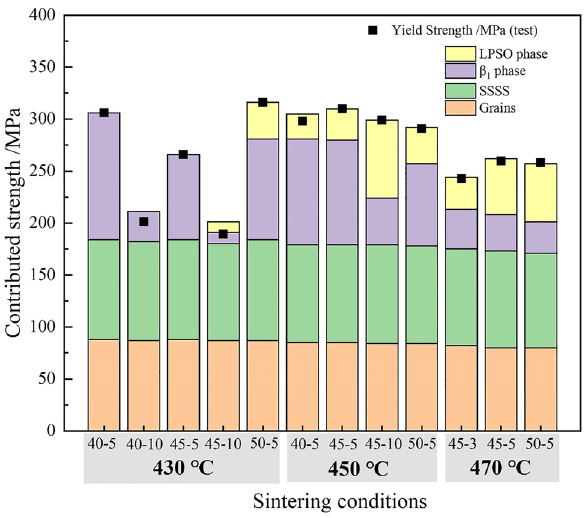
Figure 11. The yield stress contribution of the sintered samples, including four parts: refining grains, SSSS, β 1 phase and LPSO phase. The calculation process was based on Hall–Petch relation, solid-solution strengthening relation, and Orowan relation 25,35 , the detailed information was shown in Table S3. The black square dots was the actual tested yield